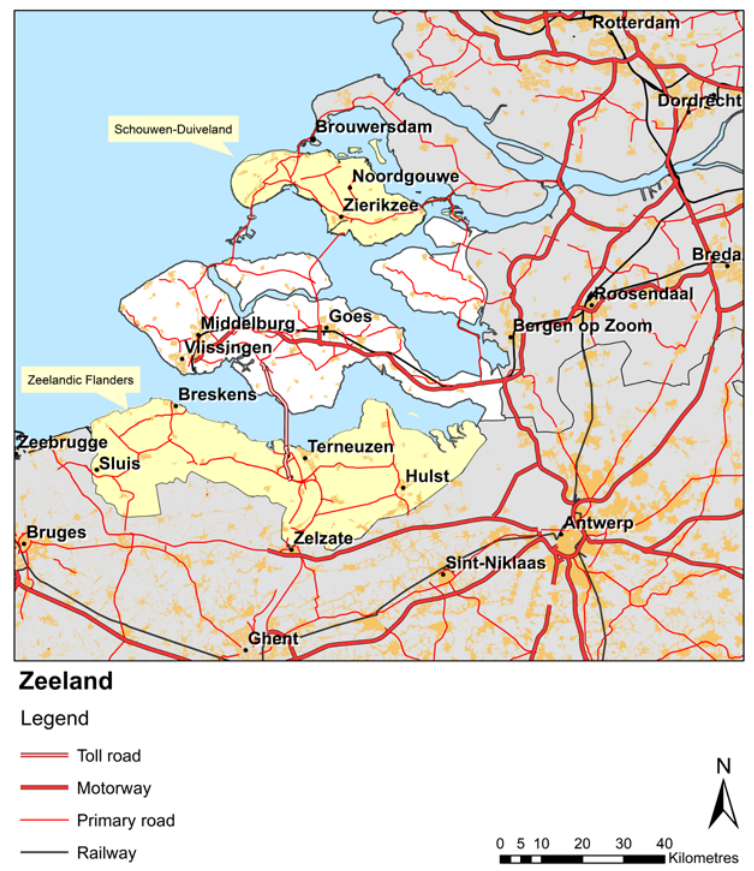
Figure 2. Study areas and their topographical